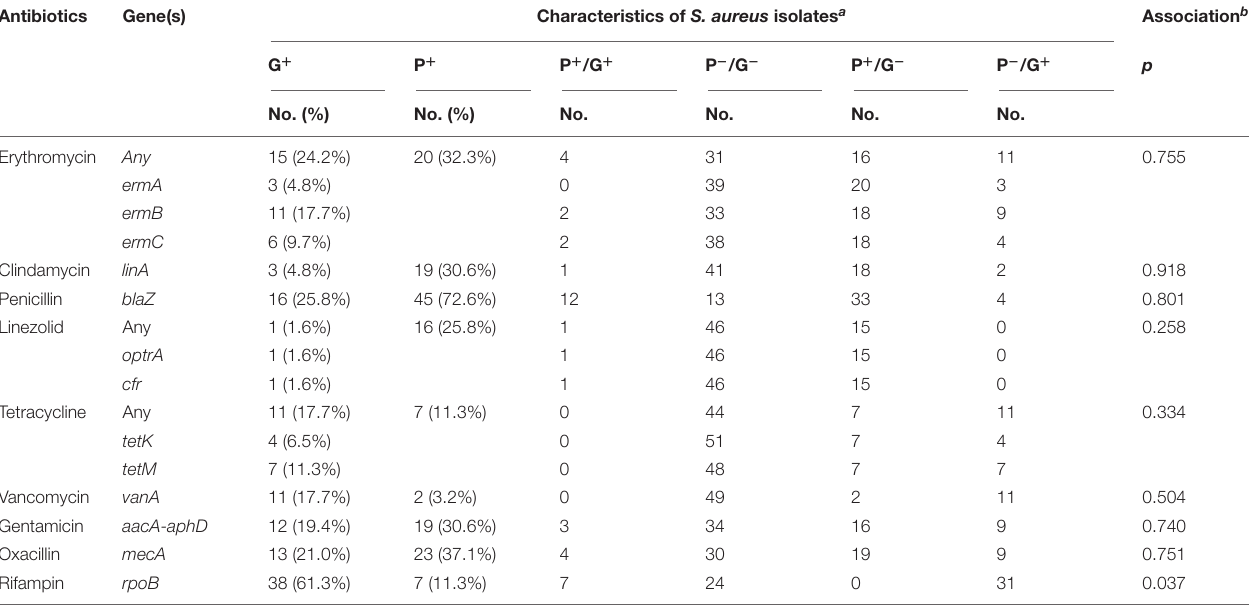
TABLE 6 | Comparison of phenotypic and genotypic characteristics for antibiotic resistance in S. aureus isolates. Antibiotics Gene(s) Characteristics of S. aureus isolates a Association b